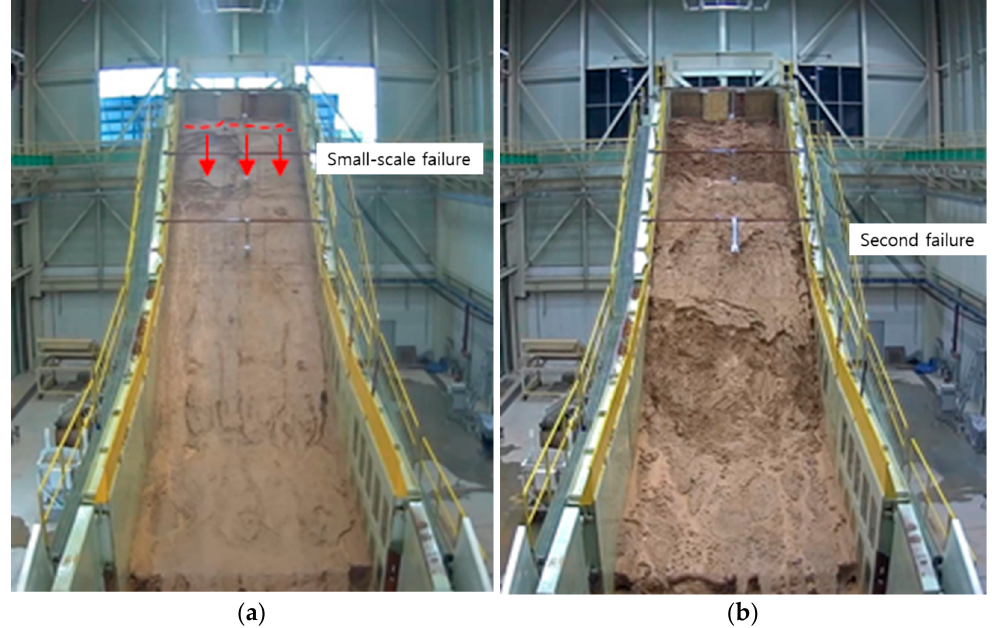
Figure 13. Full-scale flume experimental results (first experiment): ( a ) small-scale failure; ( b ) second failure (shallow failure).